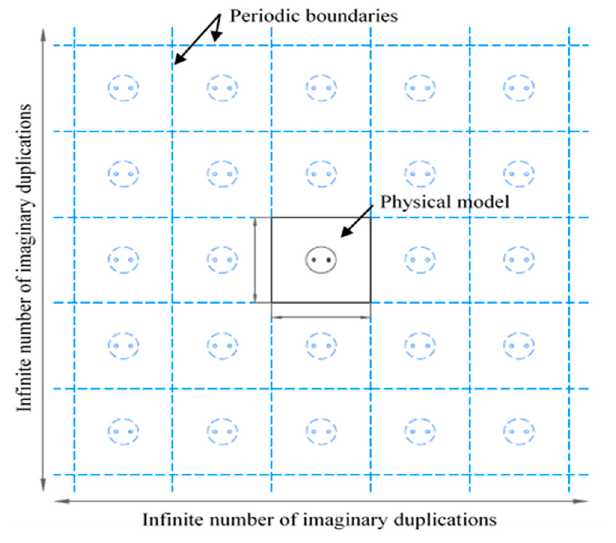
Figure 4. Sketch of the computational domain of the infinite square array.